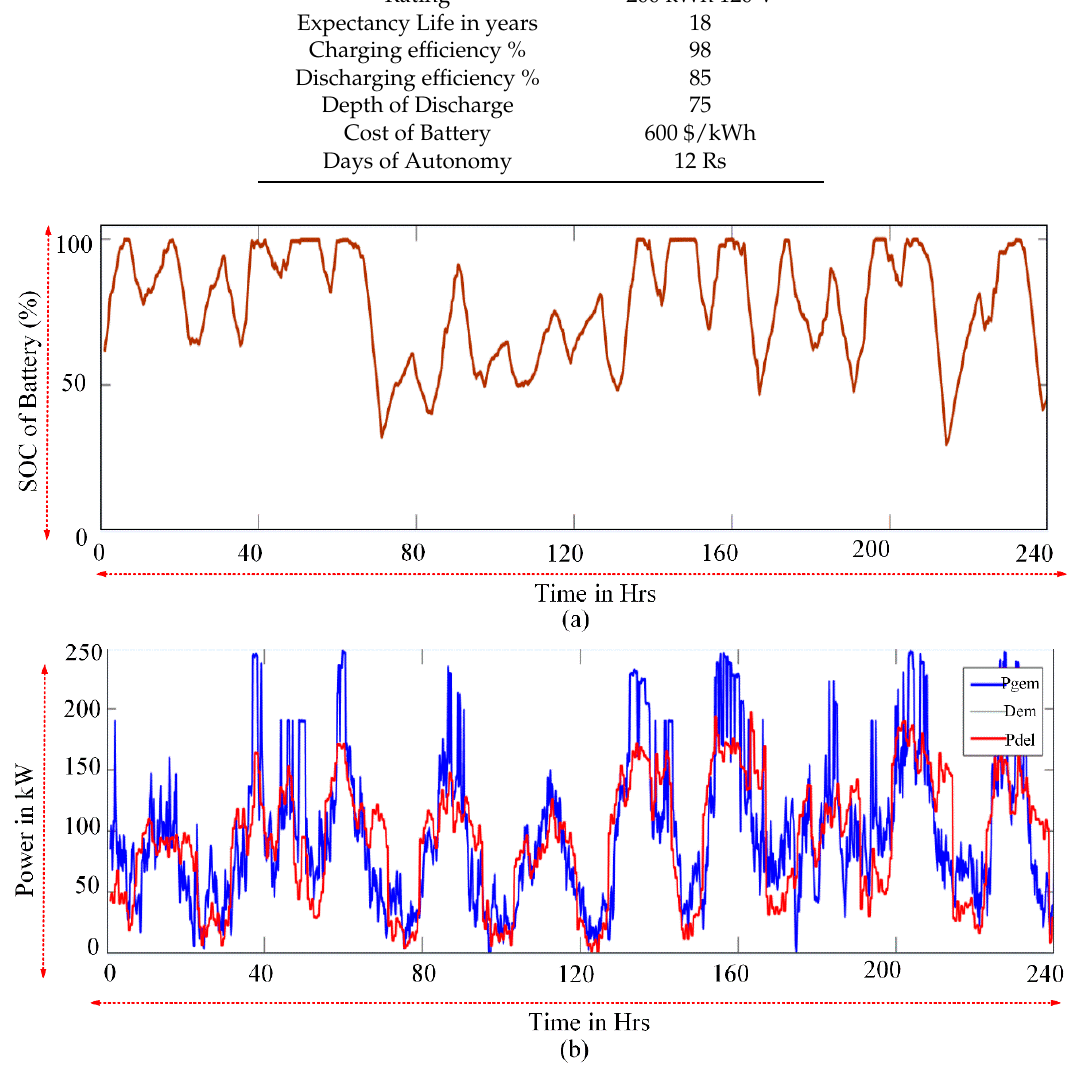
Figure 6. Single Battery Case Simulated Results ( a ) State of Charge (SOC) of Single VRB battery ( b ) Actual Power delivery by the HRES P del plotted against Power Dispatch Dem and Power Generated P gen.